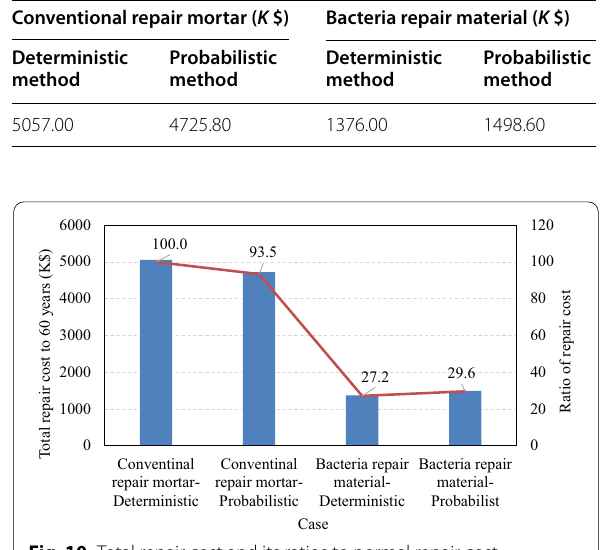
Fig. 10 Total repair cost and its ratios to normal repair